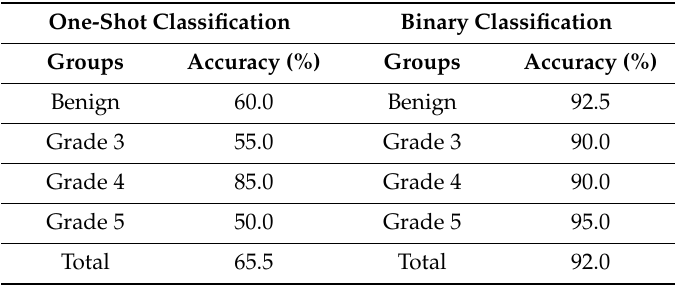
Table 7. Support vector machine (SVM) classifier, comparison between one-shot and binary classification.